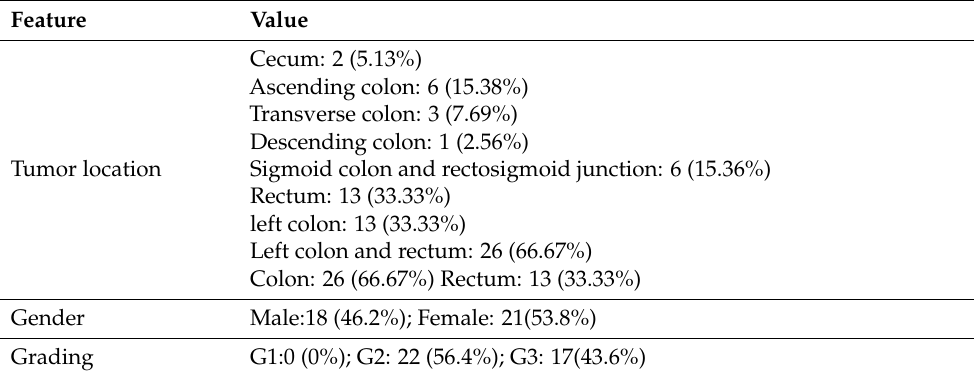
Table 1. Clinicopathological characteristics of the study